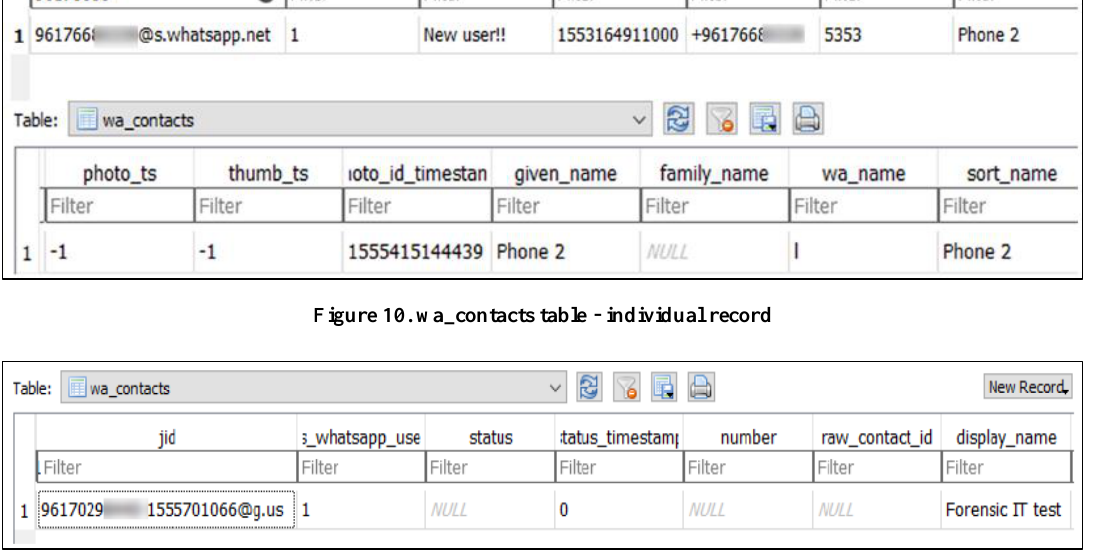
Figure 11. wa_contacts table - group record